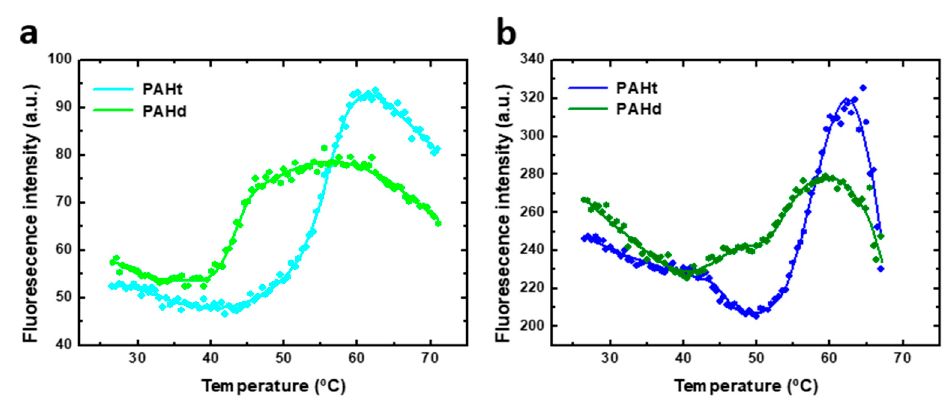
Figure 6. Thermal-induced denaturation of human PAH protein at different protein concentrations. Denaturation was monitored by fluorescence intensity at 345 nm (excitation at 295 nm) of ( a ) 0.8 µM of full-length PAHt construction and truncated PAHd construction, and ( b ) 5 µM of PAHt and PAHd. Continuous lines correspond to the nonlinear fitting curve obtained for a three-states folding model. Reported midtransition temperature values (T m1 and T m2 ) correspond to the average of individual nonlinear fittings of two or three thermal unfolding curves.